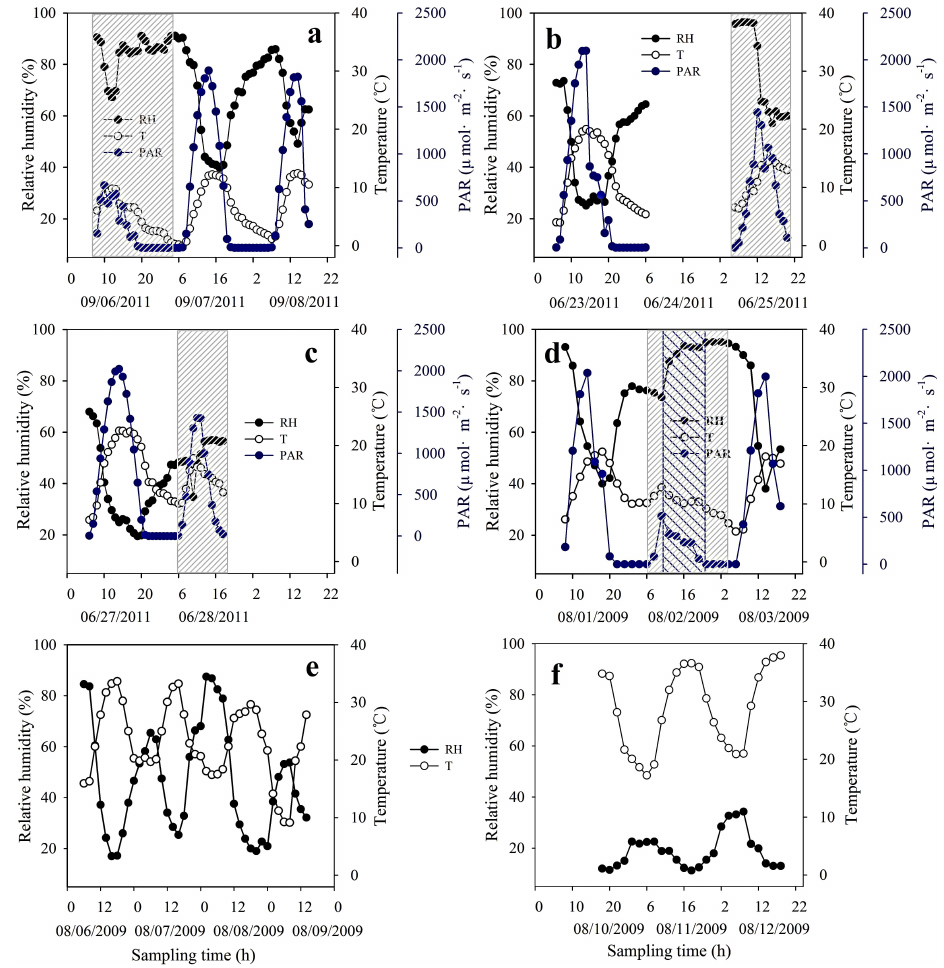
Figure 2. Comparison of hourly average relative humidity (RH), air temperature ( T ) and photosynthetically active radiation (PAR) during the experimental period. The dark cycles and the white cycles indicate the RH and T at each site. The grey shadow and the blue shadow (the one in panel d) indicate cloudy days and rainy days. Panels (a) , (b) , (c) and (d) refer to the Qinghai spruce forest of S1-Sep, S1-Jun, S2-Jun and S3-Aug. Panels (e) and (f) refer to S4-Aug and